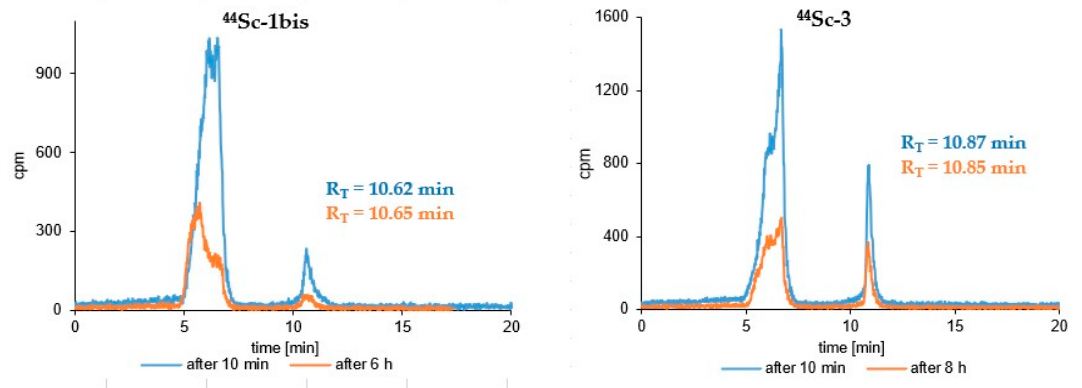
Figure 4. RP-HPLC radiochromatograms of human serum stability tests of the 44 Sc-1 , 44 Sc-1bis , 44 Sc-3 (System 3) and 44 Sc-2 (System 4) radioconjugates after different incubation times.